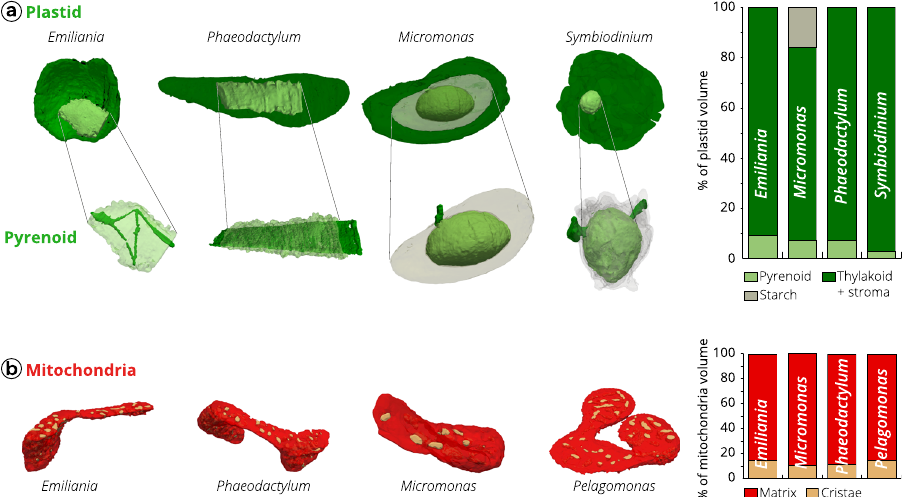
Fig. 5 Architecture of the mitochondria and plastids of different phytoplankton taxa. a Topology of the plastid. Whole plastid images and focus on the CO 2 - fi xing compartment (pyrenoid) topology in Emiliania, Phaeodactylum, Micromonas and Symbiodinium cells. The 3D reconstruction displays the thylakoid network (dark green) crossing the pyrenoid matrix (light green). If present ( Micromonas and Symbiodinium ), a starch layer surrounding the pyrenoid is shown in grey. The histogram recapitulates volume occupancy by sub-plastidial structures (thylakoids, matrix, starch, pyrenoid). Note that starch is cytosolic in Symbiodinium , and therefore its volume is not considered in the graph. b Topology of mitochondrial compartments. Red: mitochondrial matrix; yellow: cristae. The histogram recapitulates volume occupancy by mitochondrial subcompartments (in the matrix and within the cristae). See Supplementary Fig. 4 for sections through plastids and